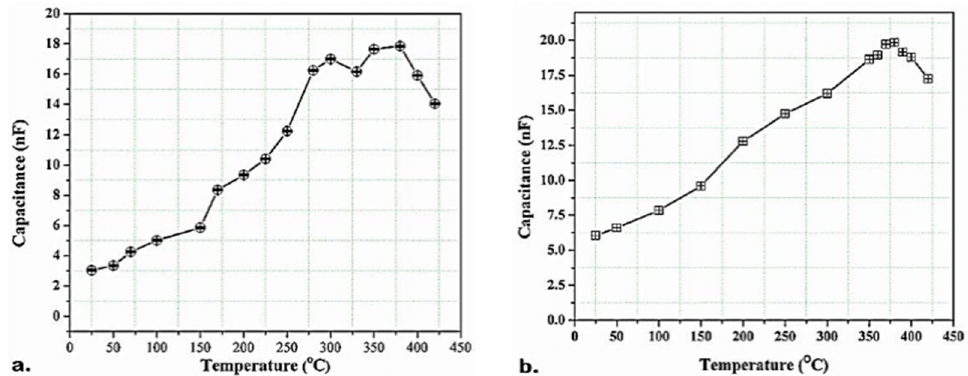
Figure 8. Capacitance-temperature ( C-T ) variations for the PZT/BiT films at 25–420 ◦ C, ( a ) L 1 -A and ( b ) L 1 -B.